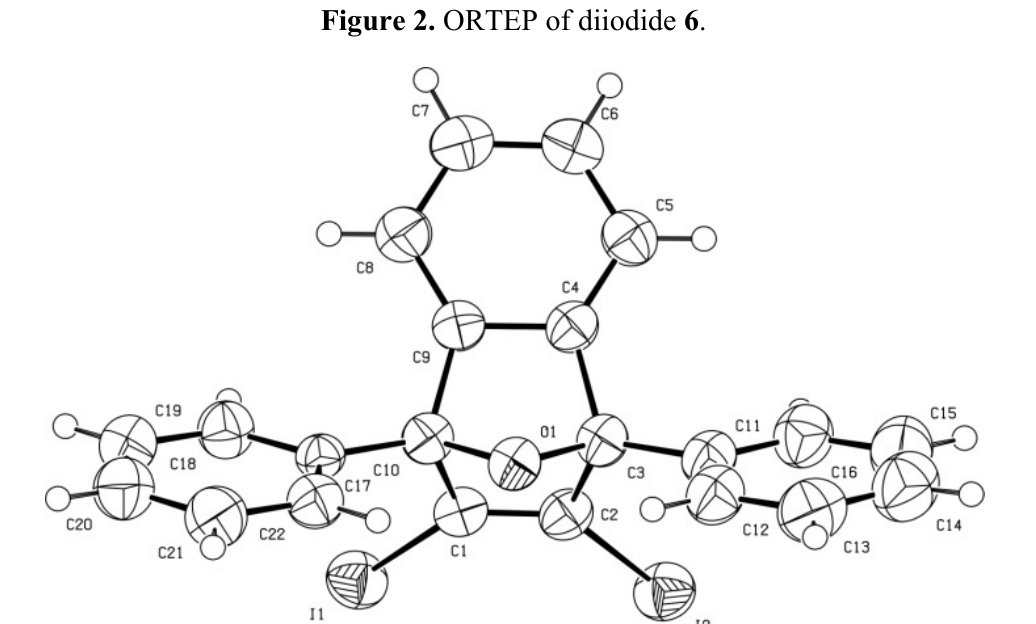
Figure 2. ORTEP of diiodide 6